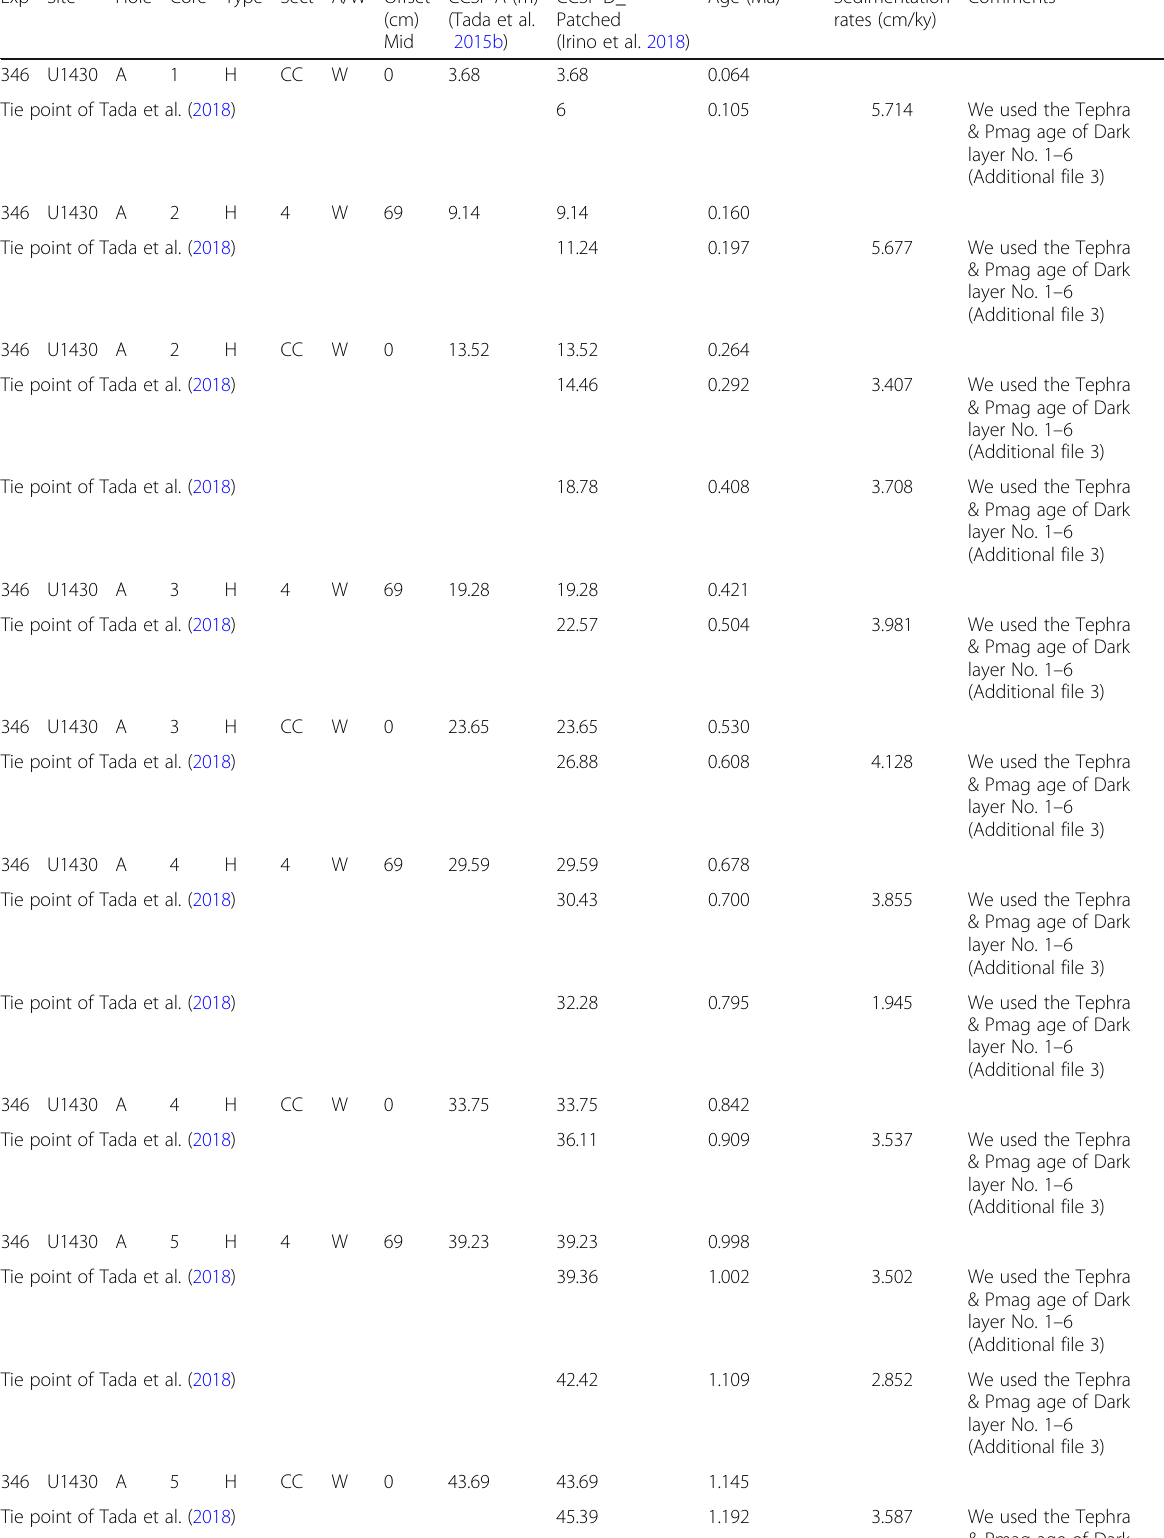
Table 2 Samples used, biostratigraphic tie points, and related sedimentation rates at IODP Site U1430